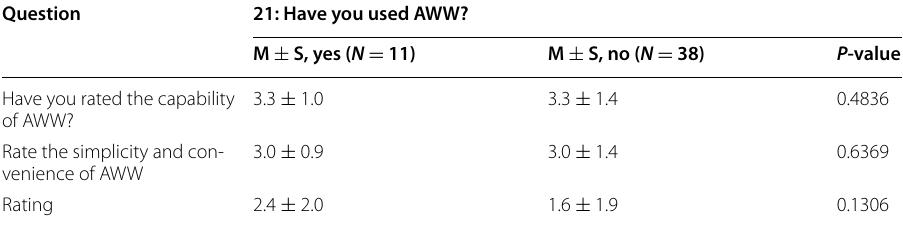
Have you rated the capability of